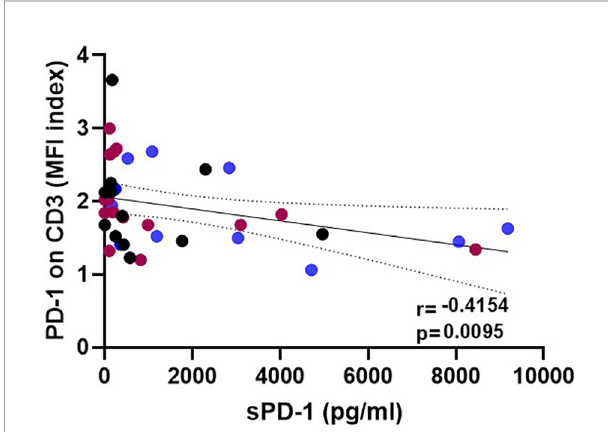
FIGURE 2 | Inverse correlation of post-HSCT sPD-1 levels with surface expression on CD3+ T cells. Plasma samples and corresponding peripheral blood lymphocytes were taken at various time points: blue, brown, and black dots correspond to 1, 2, and 3 month(s) post HSCT, respectively; solid line indicates regression line; dotted lines represent the corresponding 95% con fi dence bands; r: correlation coef fi cient